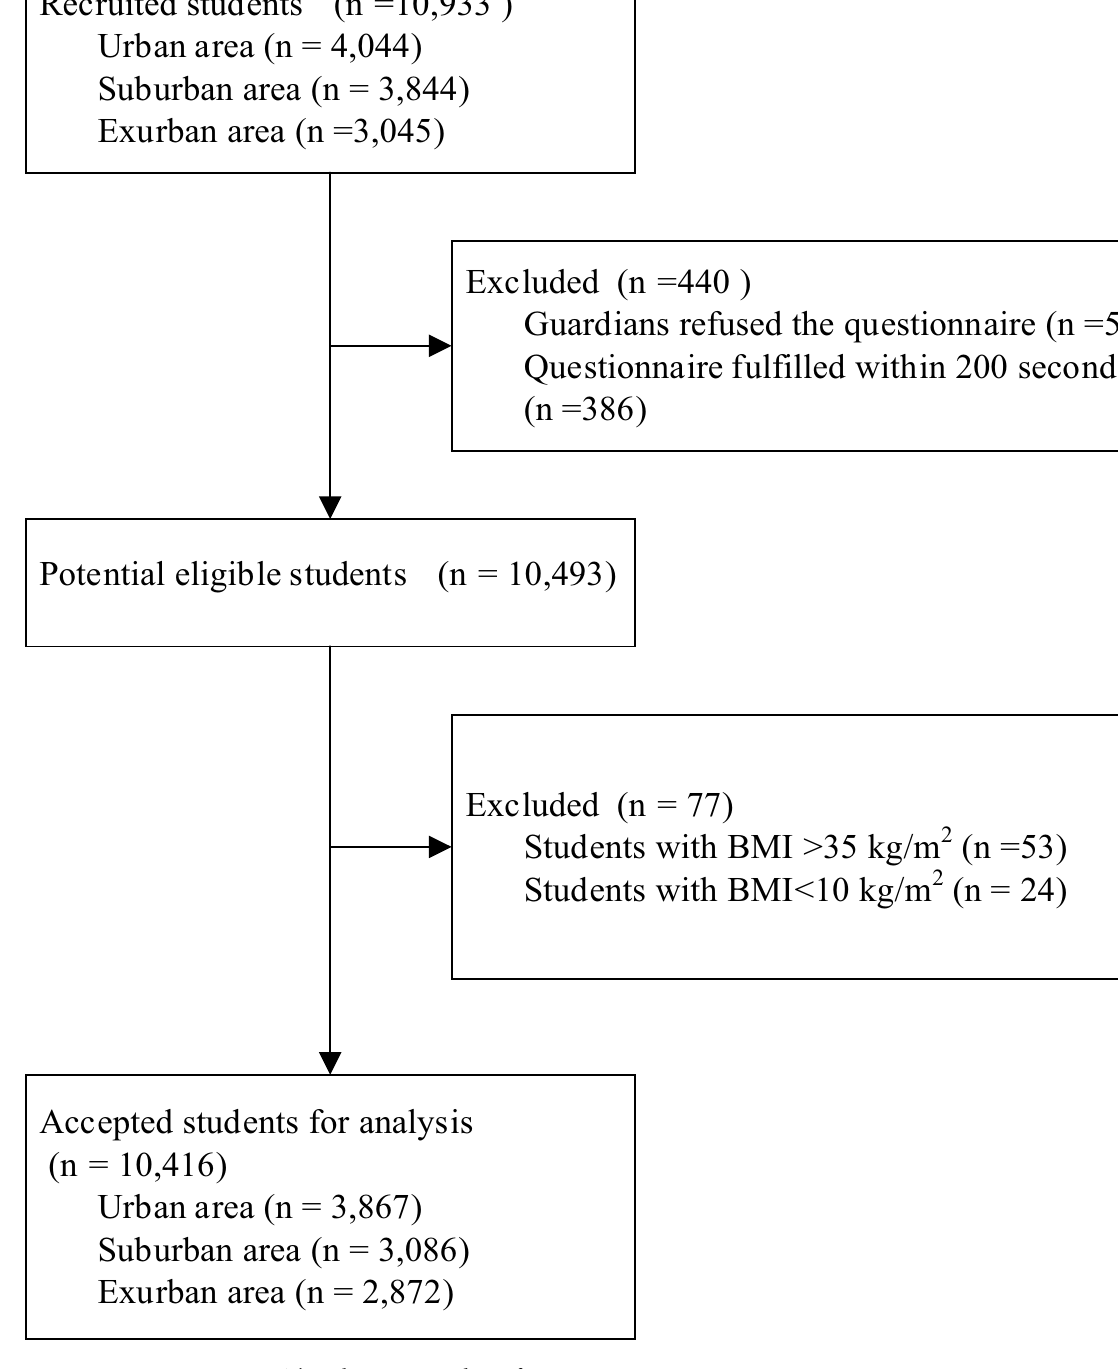
Figure 1. The selection procedure of